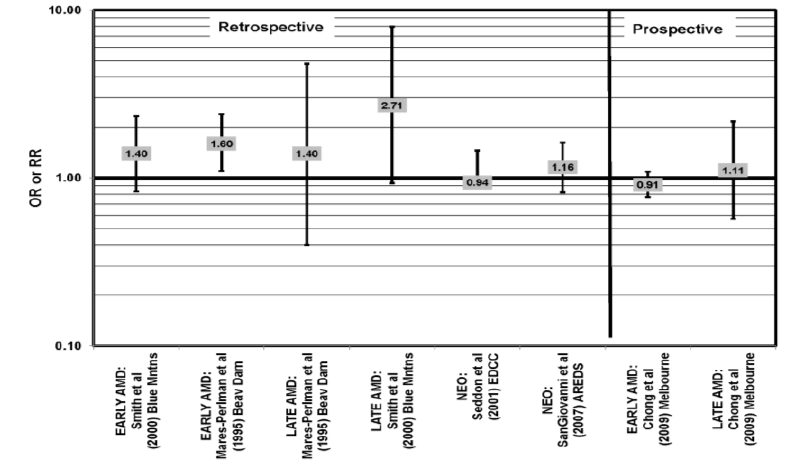
Figure 21. Odds or risk ratio for early AMD, late AMD or neovascular AMD (NEO); high vs. low intake of dietary cholesterol: retrospective and cross-sectional